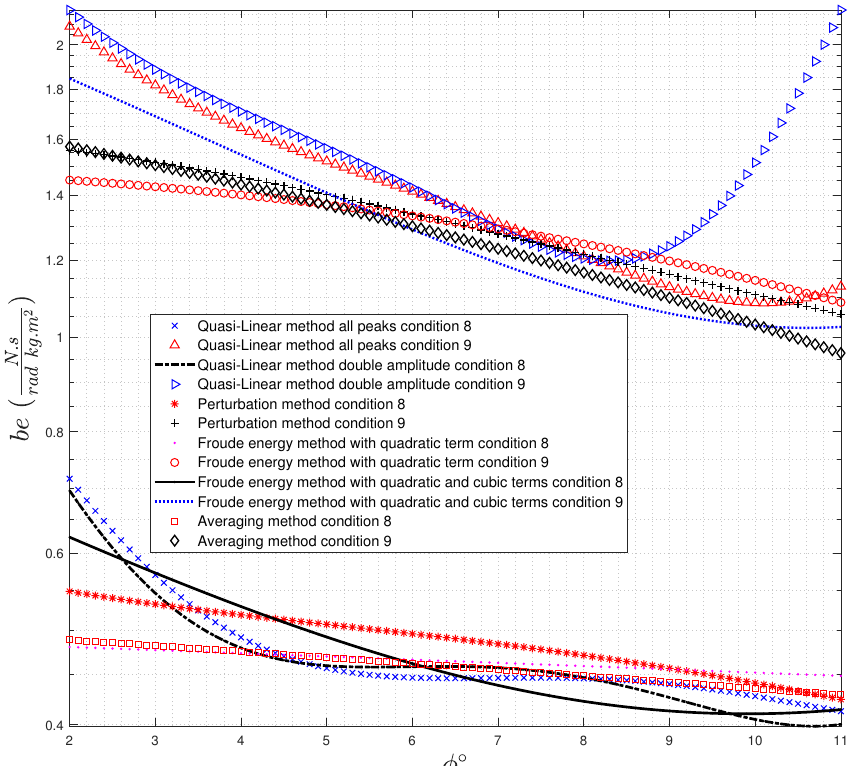
Figure 14. The effect of the vessel draft on the equivalent linear damping coefficient b e using different decay analysis methods. Condition 8 has a shallow draft equivalent to an unloaded vessel, condition 9 has a draft equivalent to a fully loaded vessel. In both conditions all tanks have a 95 ± filling